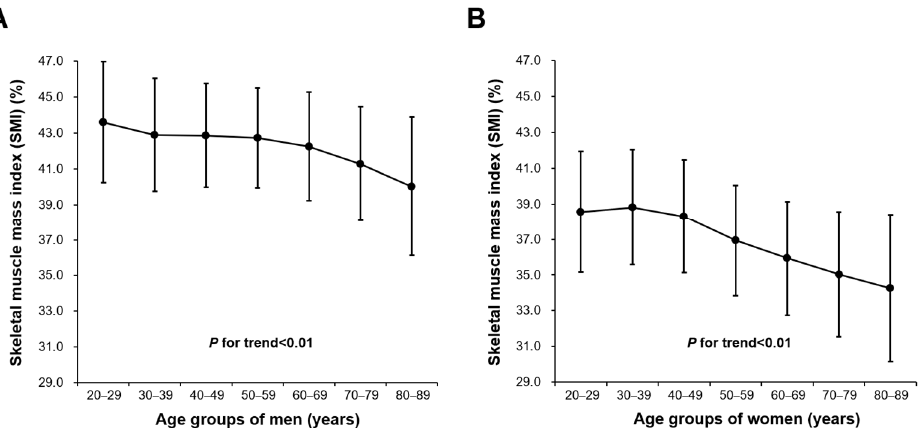
Figure 1. Means and standard deviations for SMI across age groups (20–29, 30–39, 40–49, 50–59, 60– 69, 70–79, 80–89 years) for ( A ) men and ( B ) women. SMI = skeletal muscle mass